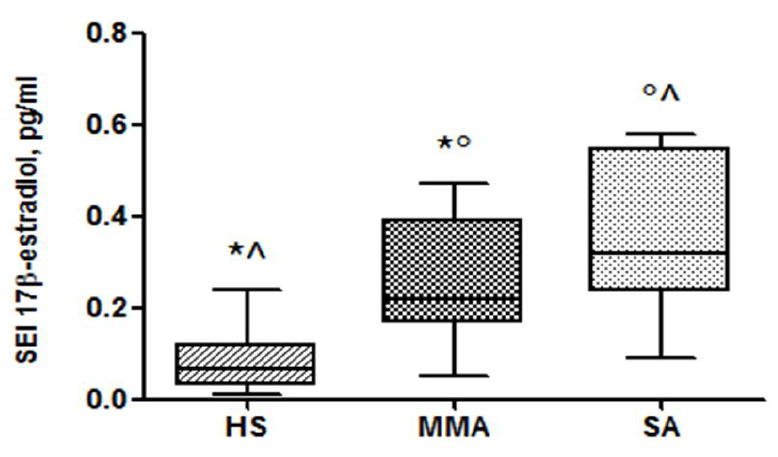
Figure 2. Induced sputum supernatant (SEI) concentrations of 17 β -estradiol in HS, MMA and SA groups. * p < 0.05 HS vs. MMA, ˆ p < 0.05 HS vs. SA and ◦ p < 0.05 MMA vs. SA.